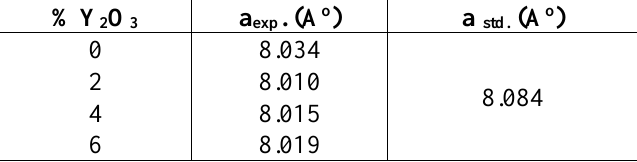
O and doped with (2, 4, and 6) %wt. of 3 4